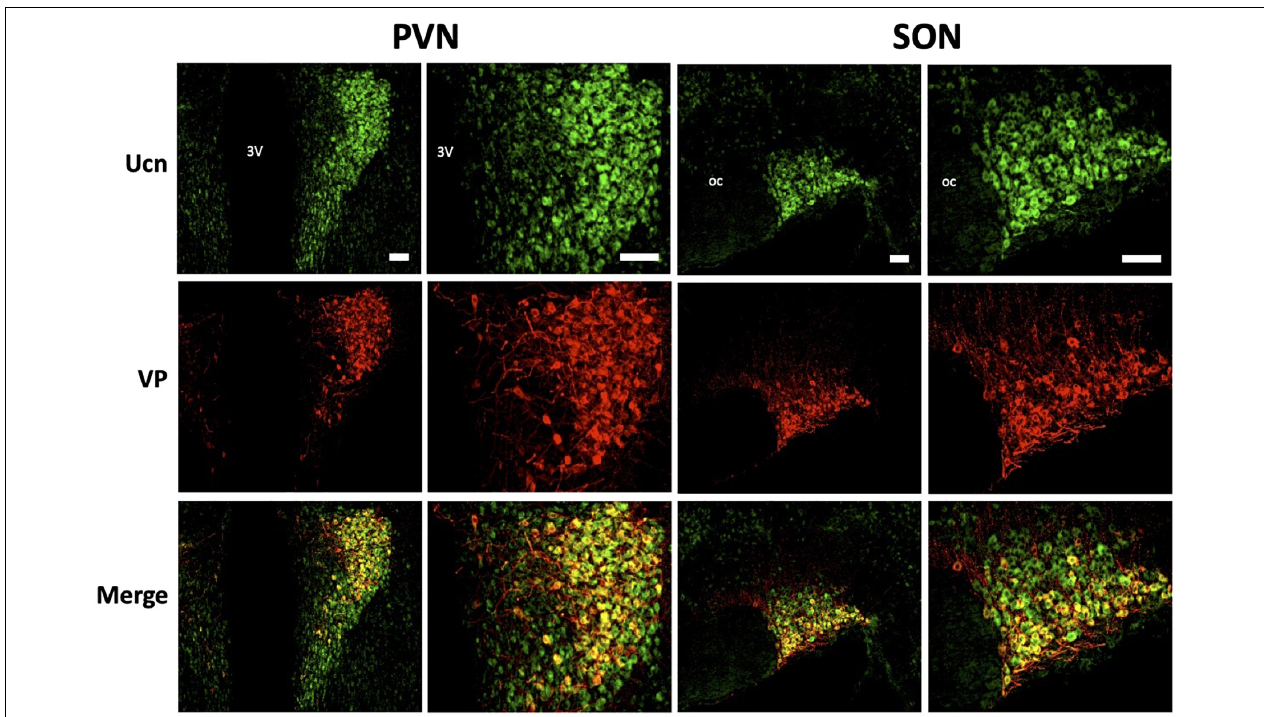
FIGURE 6 | Representative images of colocalisation of Ucn with VP in SON and PVN. Double-labelling with antibodies directed against Ucn and VP showed an apparent level of colocalisation within a proportion of vasopressinergic magnocellular cells within the PVN and SON. Images of PVN show robust staining of Ucn within a large number of neurons in the lateral as well as ventral magnocellular divisions. Images of SON show robust staining of Ucn in both dorsal and ventral divisions, however, VP staining as well as colocalisation of Ucn and VP is more limited toward the ventral aspect of the nuclei. 3V, Third Ventricle; oc, optic chiasm; Ucn, Urocortin; VP, arginine vasopressin. Scale Bar = 100 µ